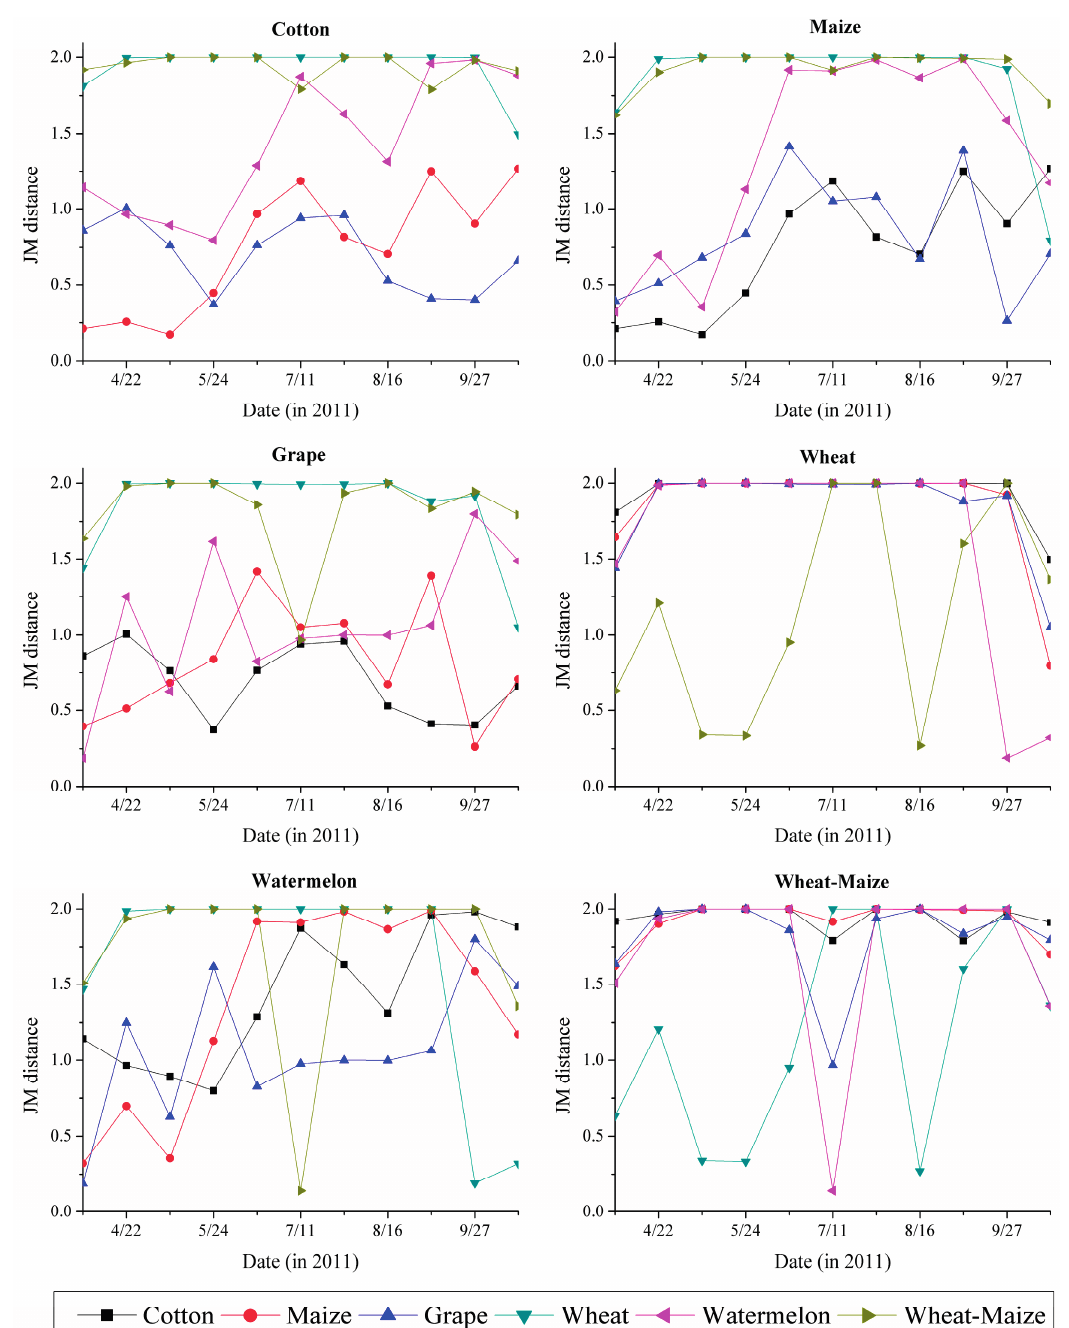
Figure 6. JM distance values for all pair-wise crop comparisons for the entire time series using training samples from